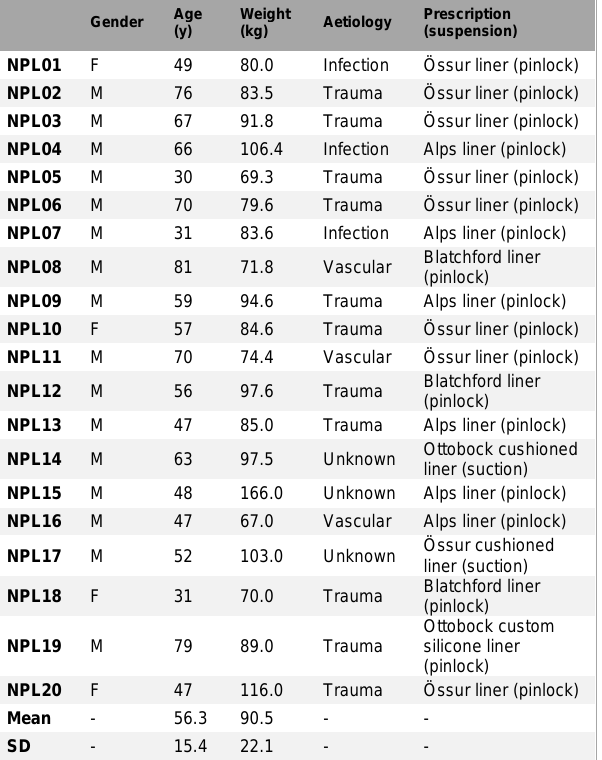
Table 2: Control group participant demographics.